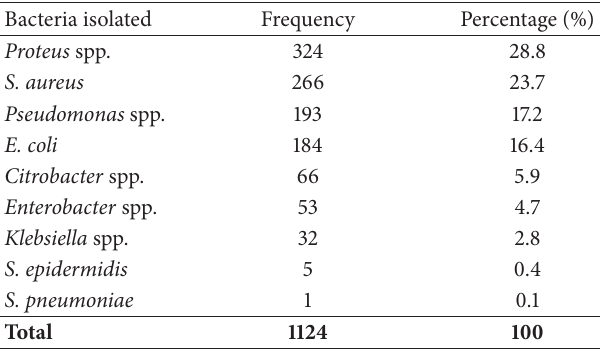
Table 2: Ten-year retrospective analysis of bacterial isolates from ear